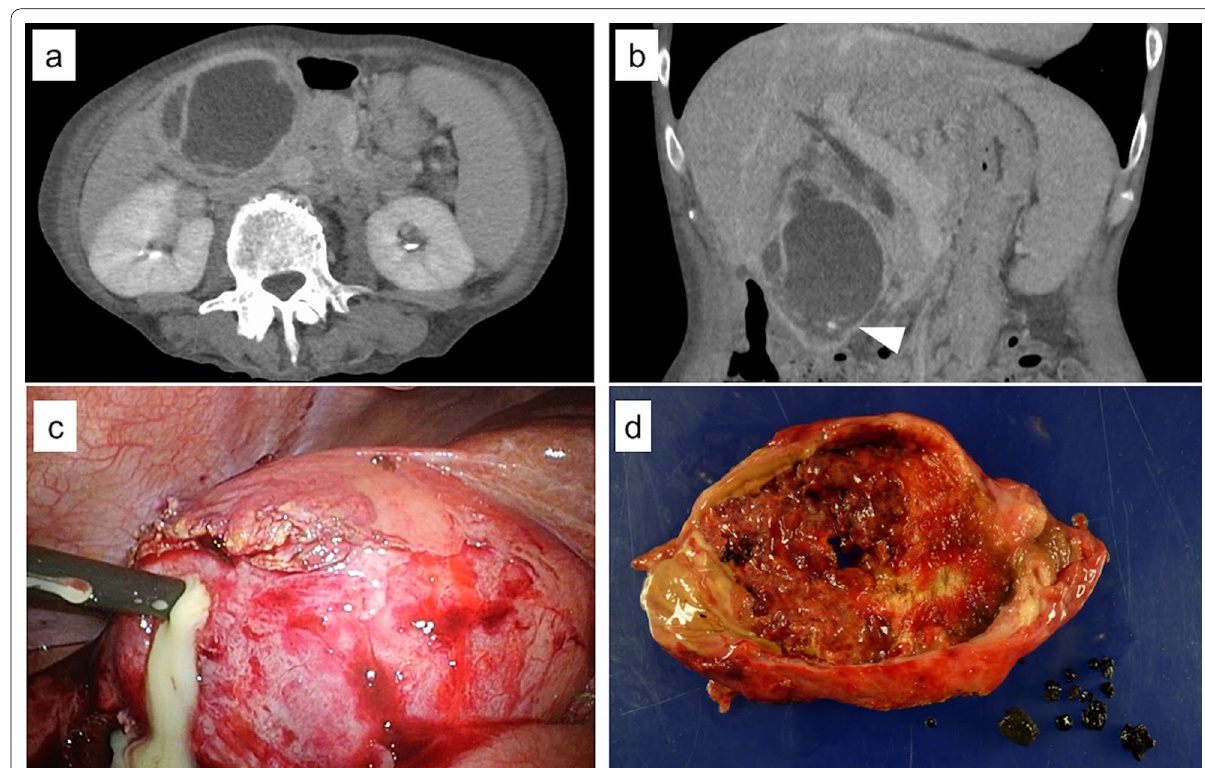
Fig. 1 CT scan and gallbladder of initial surgery. Abdominal CT performed at the time of diagnosis of cholecystitis shows marked gallbladder swelling and intramural abscess, with gallstones (arrowhead): a axial and b coronal views. c Laparoscopic cholecystectomy for acute cholecystitis. Iatrogenic perforation of the gallbladder due to the pus drainage. d Gallstones and gallbladder with wall thickening and mucosal